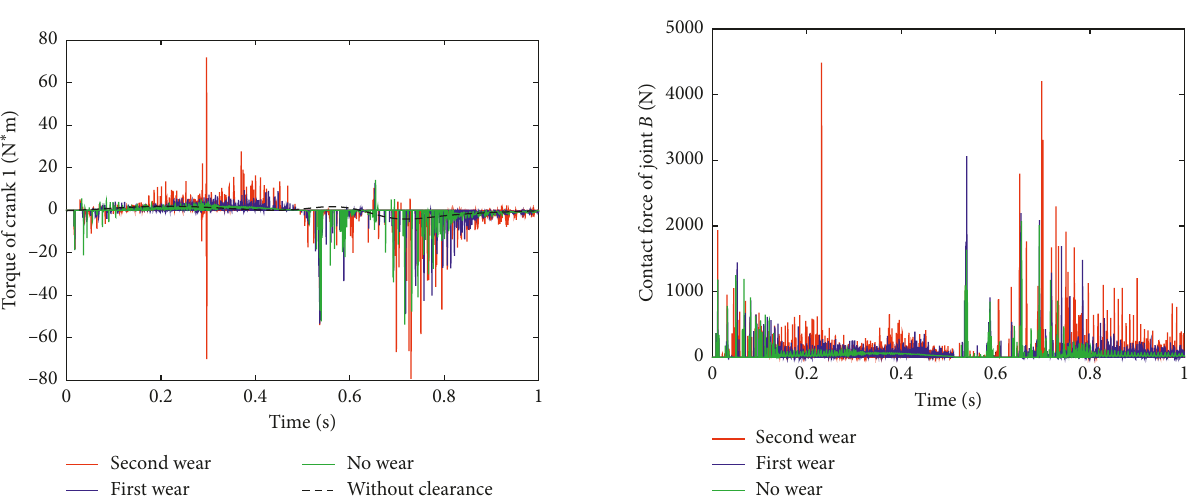
Figure 24: Contact force of joint B